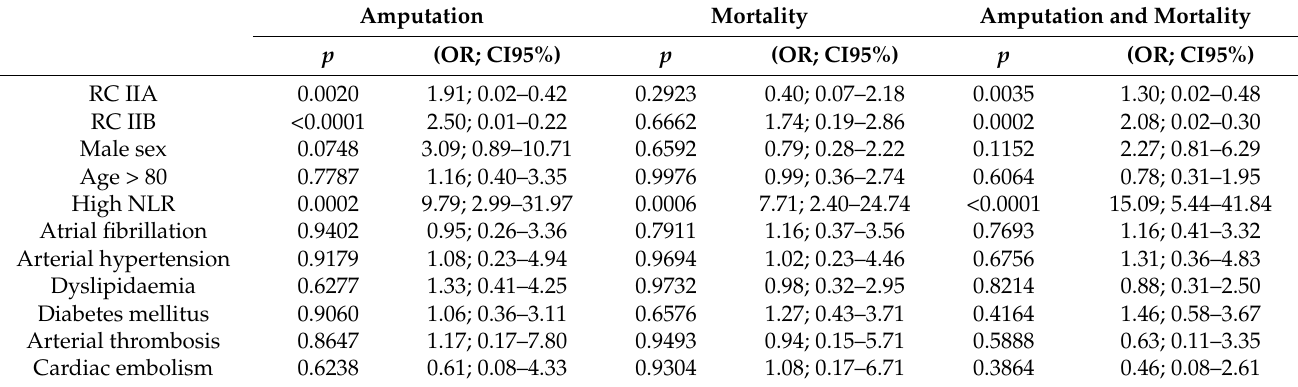
Table 3. Multivariate analysis on new adverse event occurrence during the entire study